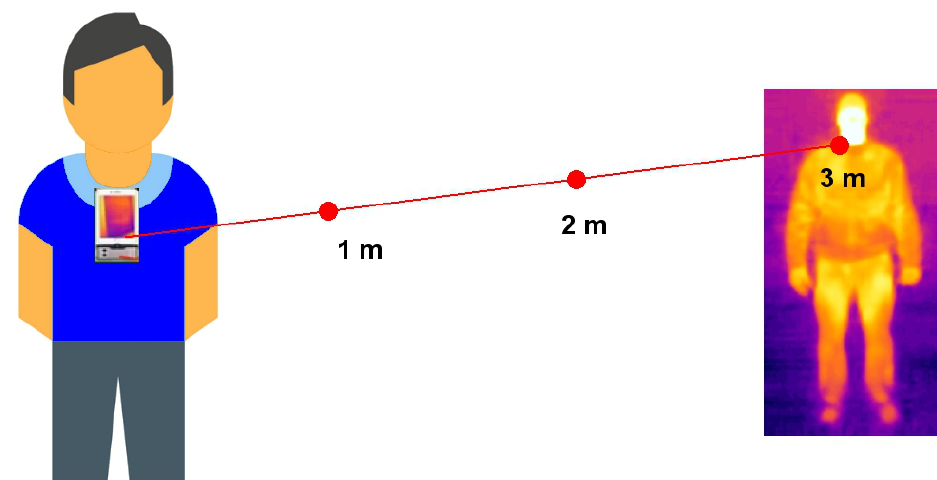
Figure 3. Attachment of thermal camera and graphic presentation of system